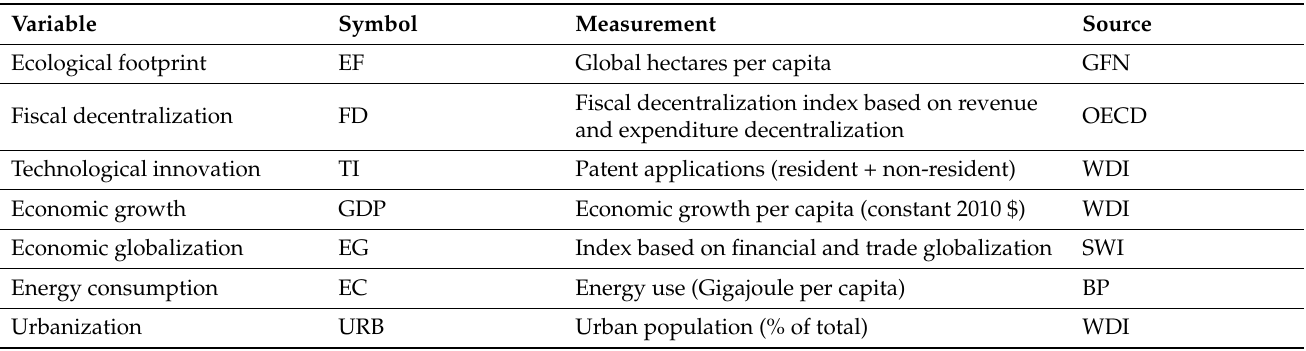
Table 1. Variable’s description.